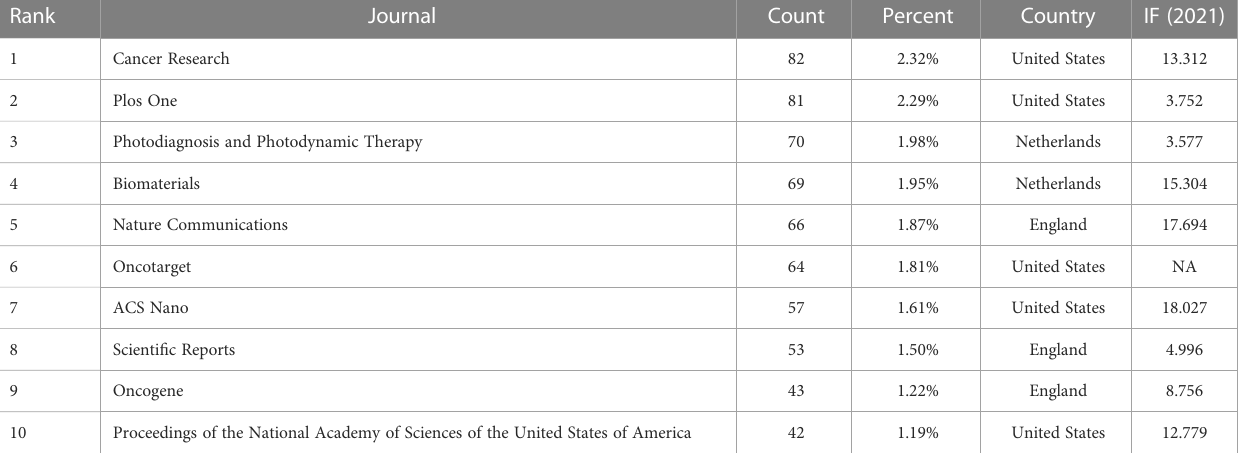
TABLE 2 The top 10 journals in the fi eld of tumor ablation and immunity from 2012 to 2021.